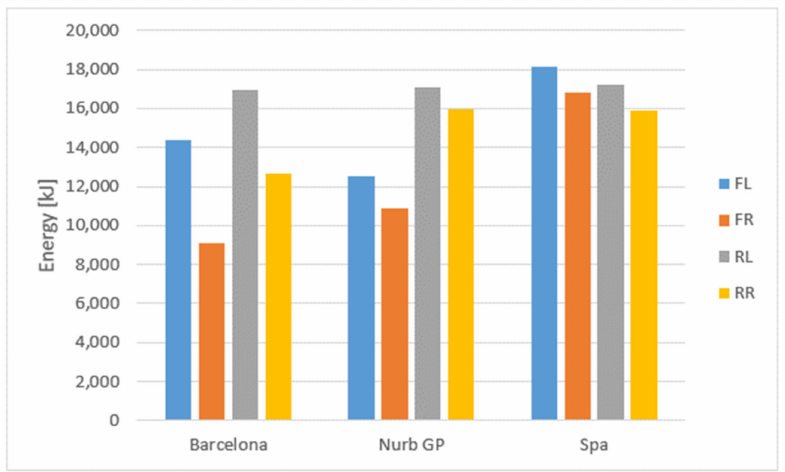
Figure 8. Tire energy sensitivity to different tracks, total energy for each wheel.